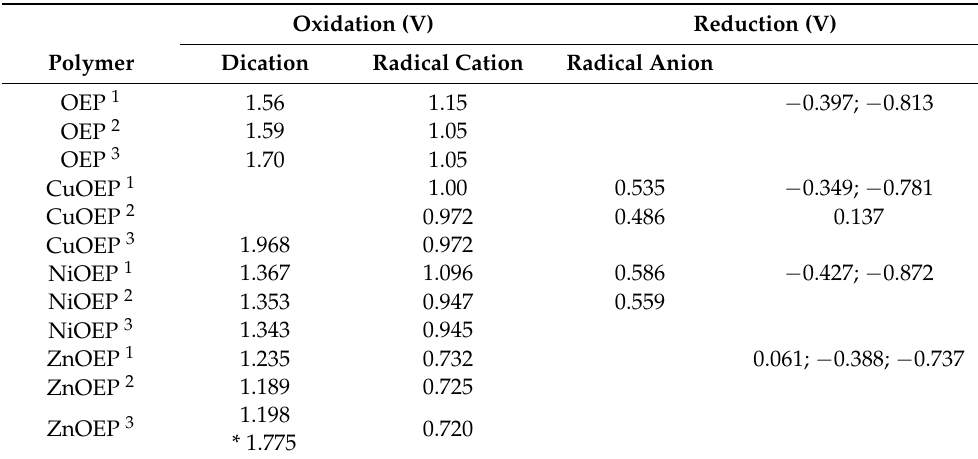
Table 1. Half-wave redox potentials (V vs. Ag/AgCl) of OEP and its metallo-complexes in different potential ranges of elecropolymerization (determined in the first